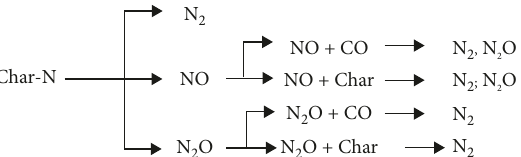
Figure 6: Simplified reaction scheme for the formation and reduction of NO and N